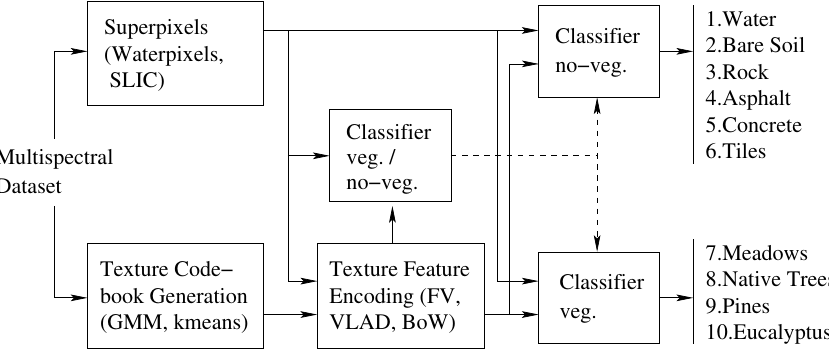
Figure 9. Diagram of the classification chain used in this